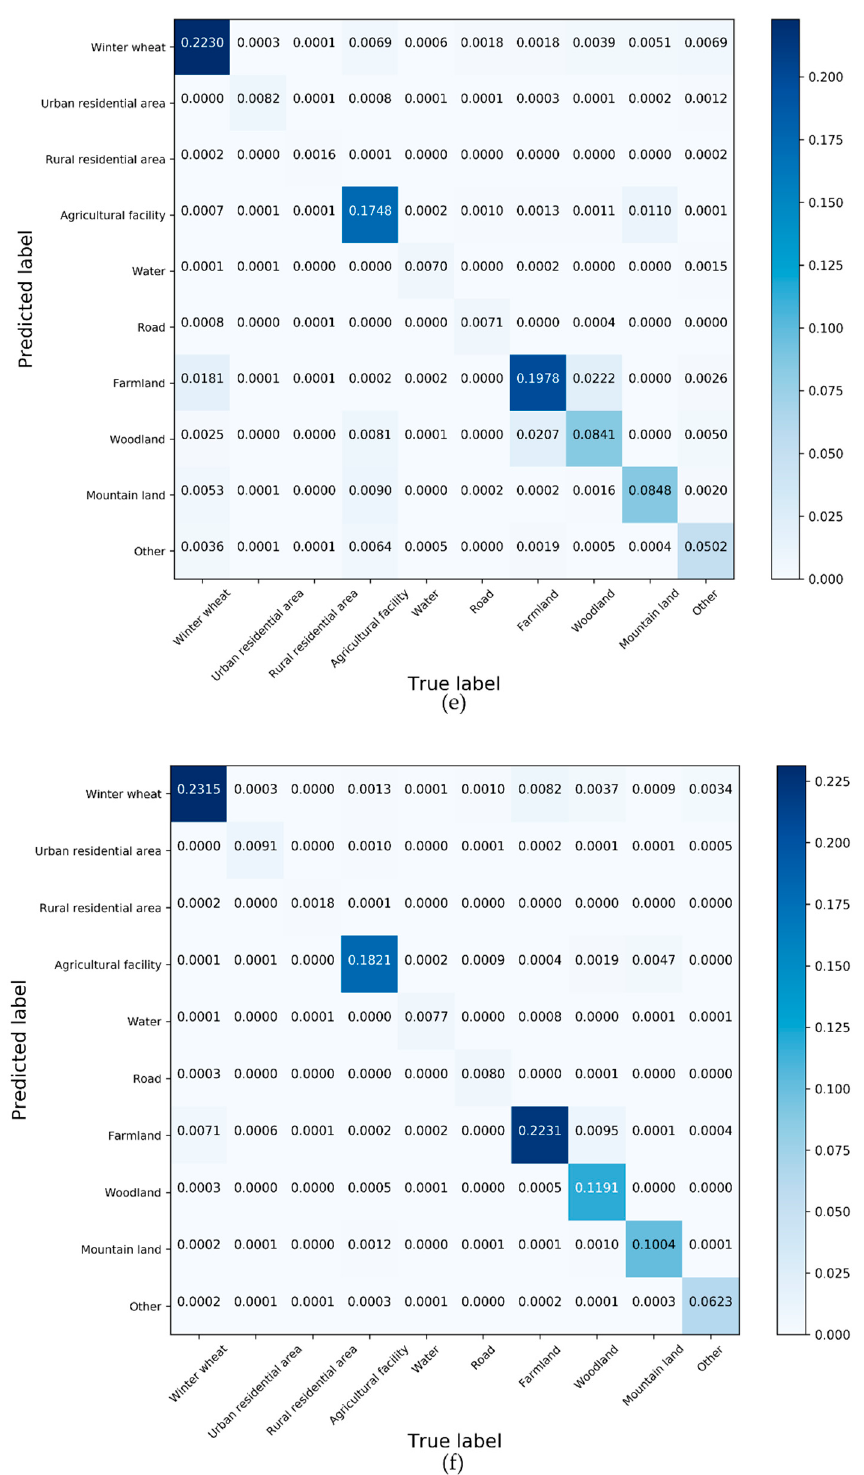
Figure 8. Confusion matrices of different models using the GaoFen-2 (GF-2) image datasets: ( a ) SegNet, ( b ) SegNet-CRF, ( c ) SegNet-PCCRF, ( d ) RefineNet, ( e ) RefineNet-CRF, and ( f ) RefineNet-PCCRF.